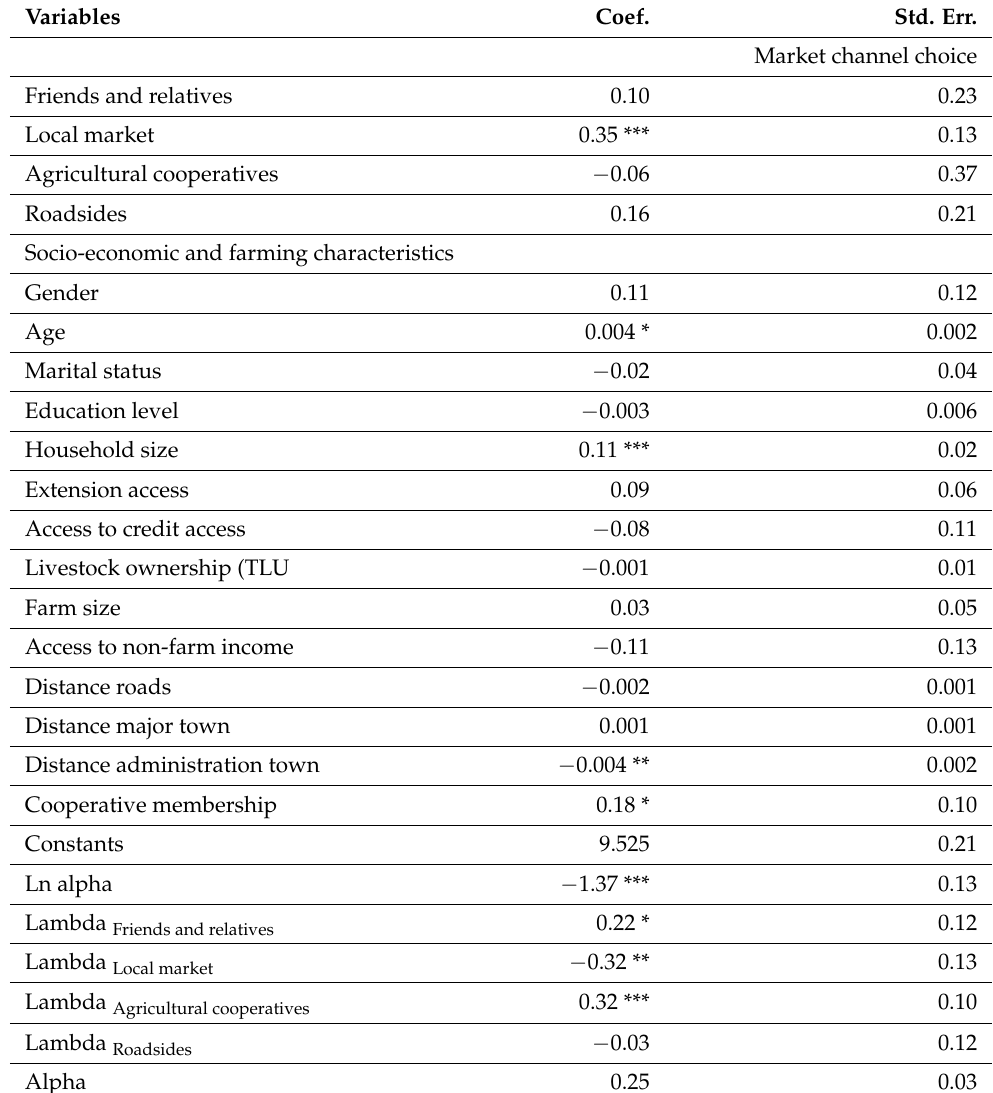
Table 4. The welfare effects of market outlet choices: selectivity